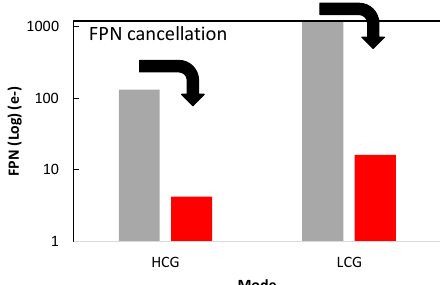
Figure 11. Measured fixed pattern noise (FPN) of high conversion gain (HCG) mode and low conversion gain (LCG) mode, with and without FPN cancellation operation under the conditions of 300 μ s exposure and average of 100 frames.